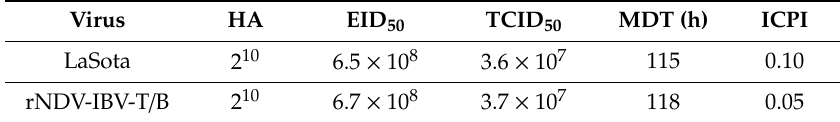
Table 1. Biological assessments between rNDV-IBV-T / B and parental LaSota. Virus